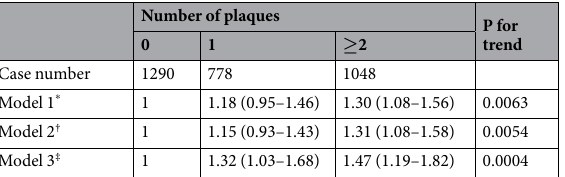
Table 2. Odds ratios of cognitive impairment by number of plaques. * Adjusted for age, sex. † Adjusted for as model 1 plus education level, marriage status, alcohol use, tobacco use, physical activity, hypertension, diabetes, hypercholesterolemia, atrial fibrillation, coronary artery disease. ‡ Adjusted for as model 2 plus NIHSS and TOAST. NIHSS: National Institutes of Health Stroke Scale; TOAST: Trial of Org 10172 in Acute Stroke Treatment.